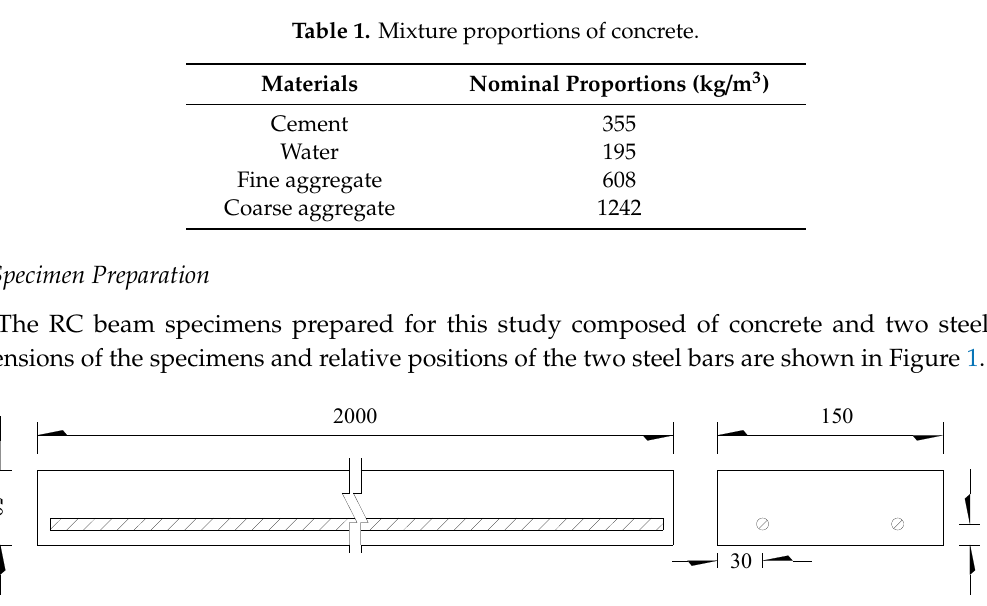
Figure 1. Front view and lateral view of reinforced concrete (RC) beam specimen (unit: mm).